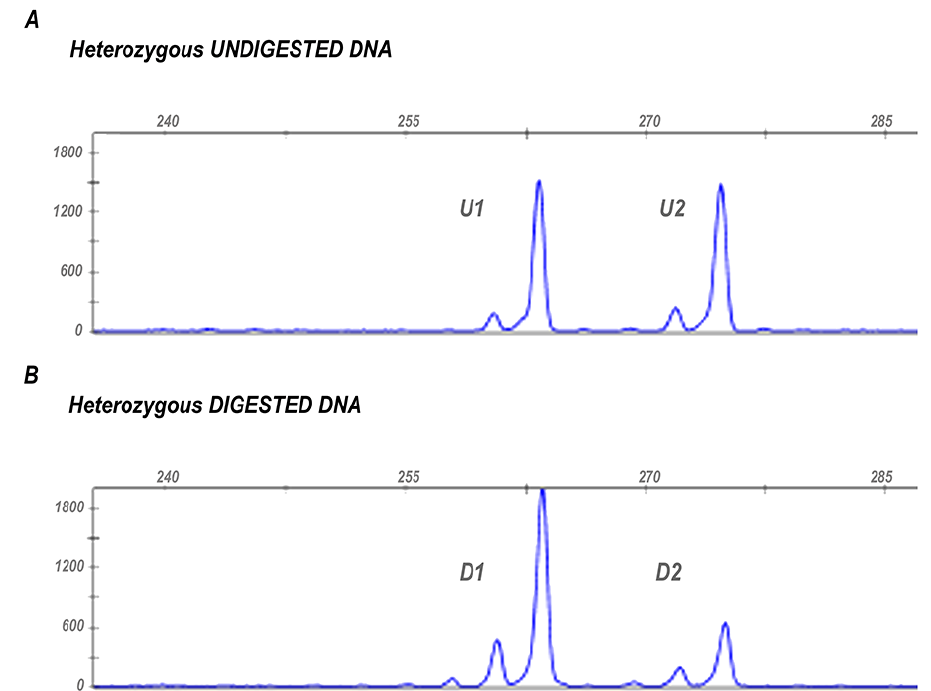
Figure 1. X chromosome inactivation pattern assessed through the HUMARA assay in an informative sample. ( A ) The figure shows the two peaks (U1 and U2) generated by the amplification of undigested AR alleles in a heterozygous subject. The different length of the two PCR products results from the polymorphic microsatellite located within the amplified region that allows the discrimination between the two parental AR alleles. ( B ) Peaks generated by the two AR alleles after digestion with HpaII and HhaI restriction enzymes (D1 and D2). The different areas of the peaks, before and after digestion, are used to estimate XCI ratio.